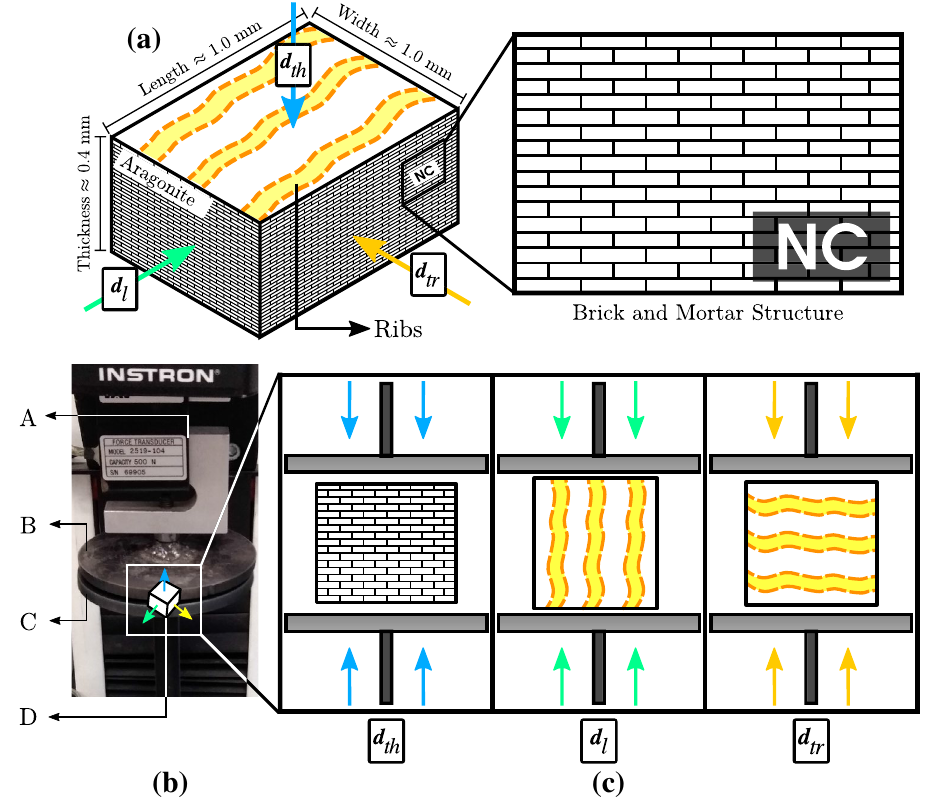
Figure 2. Uniaxial compression test assembly. ( a ) Orthotropic directions of the nacreous material (brick-and- mortar structure) represented in the sample used in uniaxial compression test. NC: nacreous layer cross-section, ( b ) A: load cell, B: mobile top plate, C: fixed bottom plate, D: sample, ( c ) arrangement of the samples according to the direction of